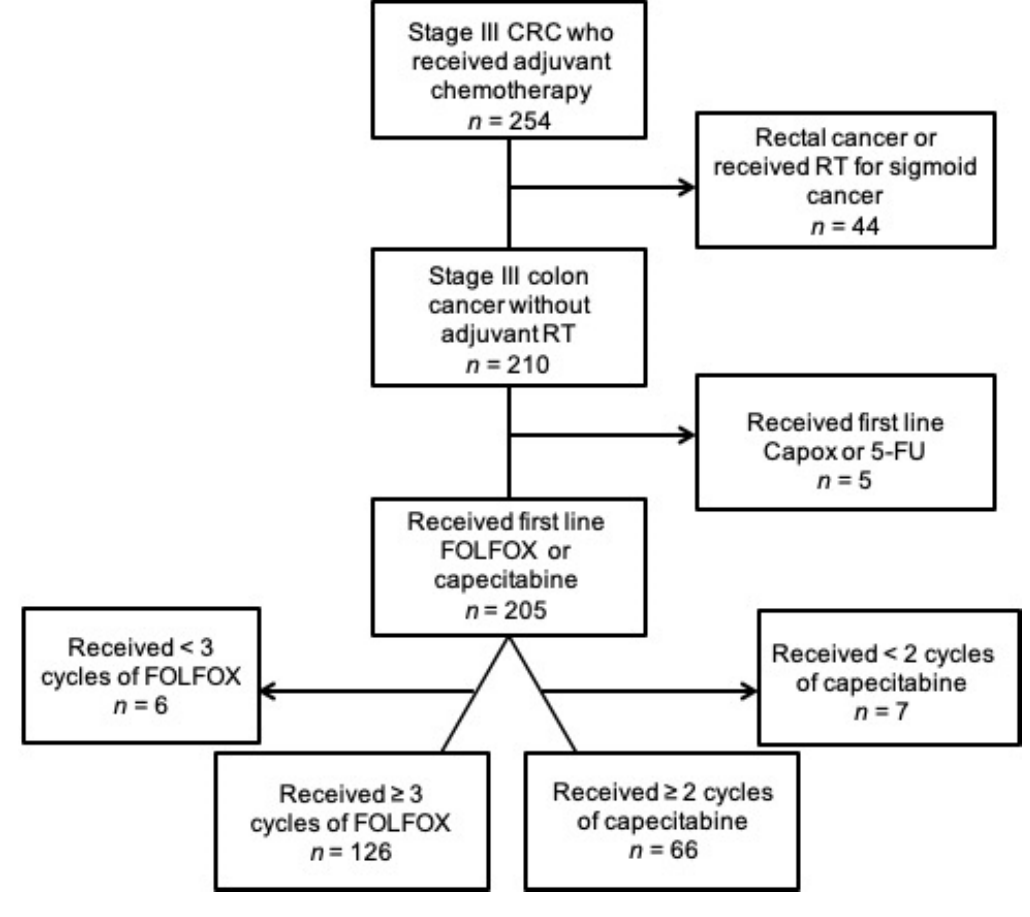
Figure 1. Summary of patient selection.